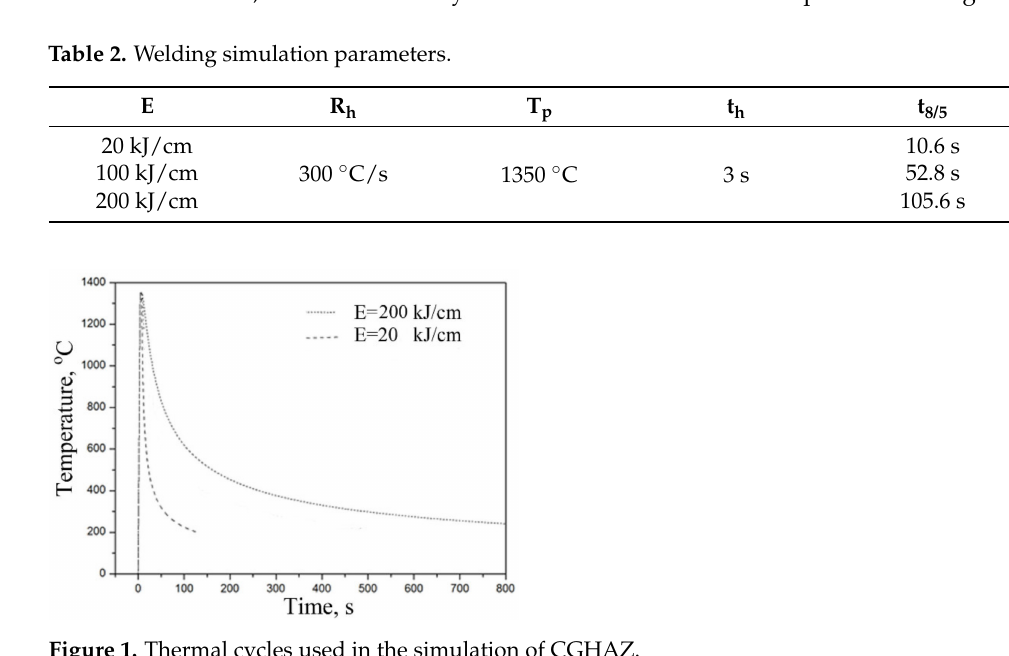
Figure 1. Thermal cycles used in the simulation of